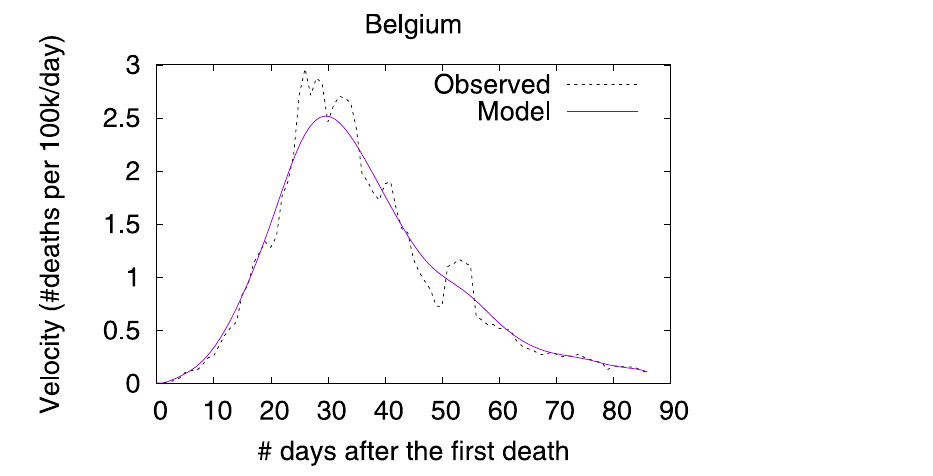
Fig 31. (Color online) projections for velocity in Belgium.